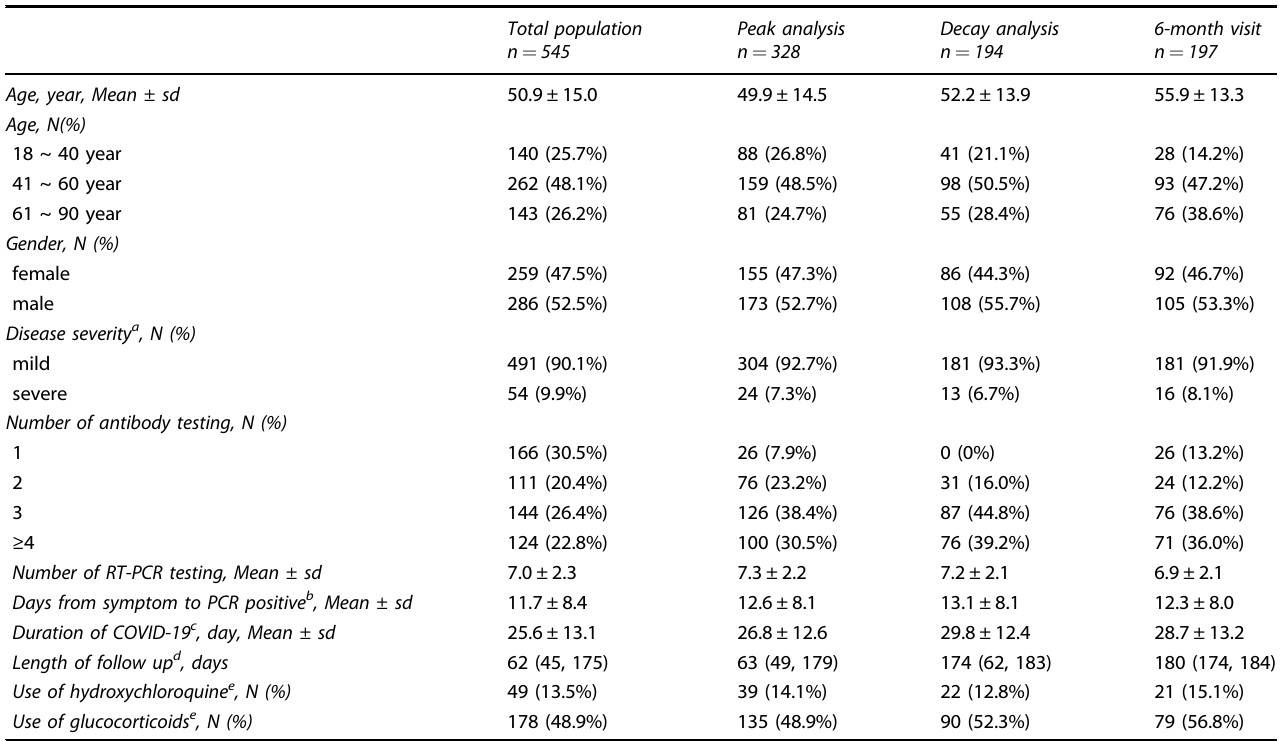
Table 1. Characteristics of the COVID-19